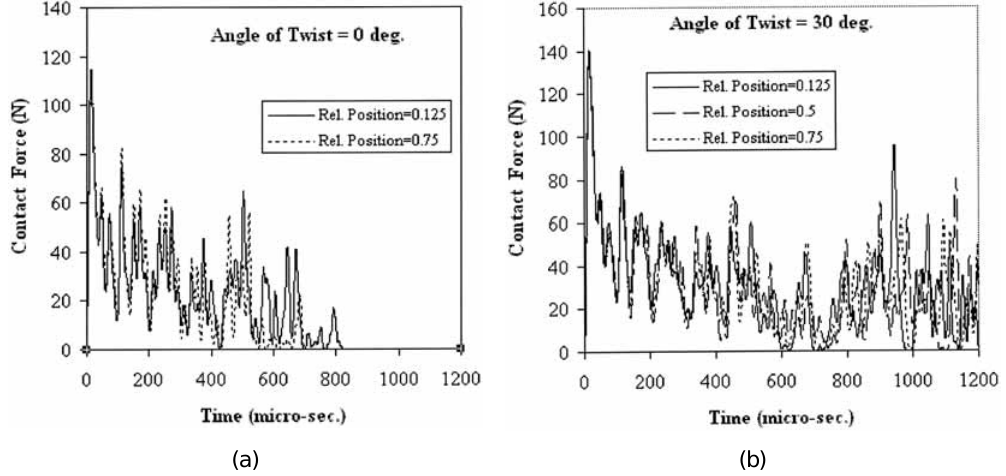
Fig.6. (a) The effect ofrelative position of delamination across thickness oncontact force forbending stiff ([0 2 / ± 30] S ) graphite-epoxy composite cantilever cylindrical shell with 25% delamination (relative position of centre line at 0.25 from the free end). (b) The effect of relative position